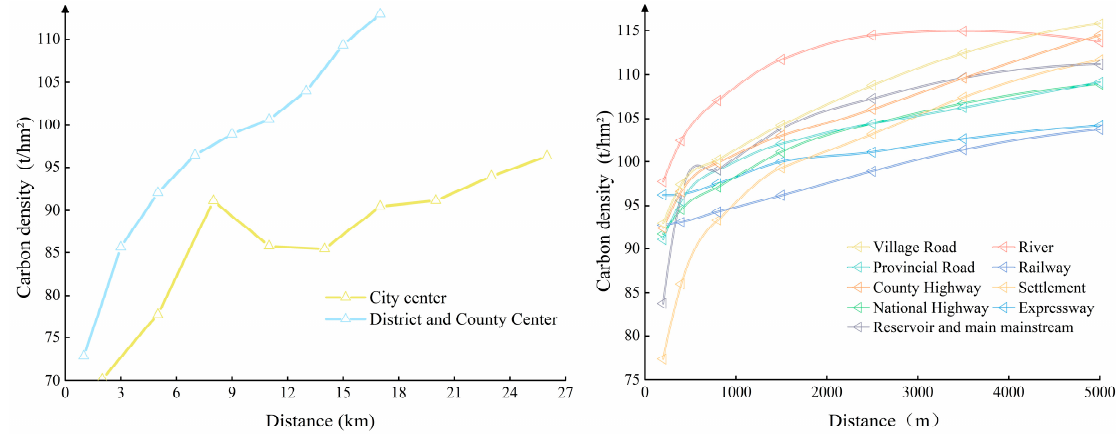
Figure 11. Carbon stock variation with distance of influence factors.